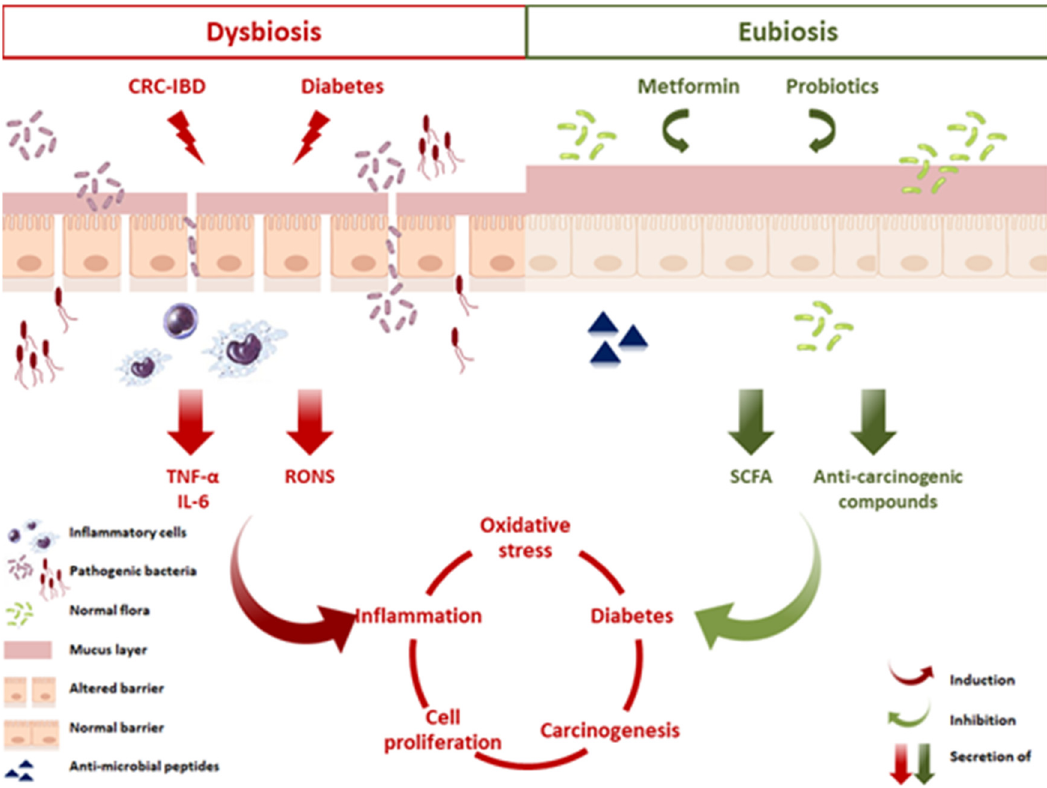
Figure 12. Proposed mechanisms of action elicited by metformin and probiotics in CRC and diabetes. An altered microbiota in a state of dysbiosis impairs the functions of the gut barrier by a ff ecting the tight junctions and the mucus layer, thus facilitating the translocation of pathogens and toxins into the lamina propria. This invasion leads to recruitment of inflammatory cells, their activation, and the secretion of proinflammatory cytokines, including IL-6 and TNF- α . In parallel, an increase in RONS production induces a state of chronic inflammation, DNA damage, and increased cell proliferation, known as key players in CRC progression. Moreover, this state of chronic inflammation promotes insulin resistance and disurbance in glucose homeostasis, thus exacerbating diabetes and enhancing CRC. Probiotics and metformin administration, however, inhibited CRC progression, reduced inflammation, and ameliorated diabetes. These benefical e ff ects are potentially linked to a restoration of the gut barrier, production of SCFA, antimicrobial peptides, regulation of hepatic glucose production, and modulating the balance between proliferation and apoptosis. The result of such a balanced miroenvironment is to preserve a dynamic intestinal barrier that controls and maintains homeostasis.